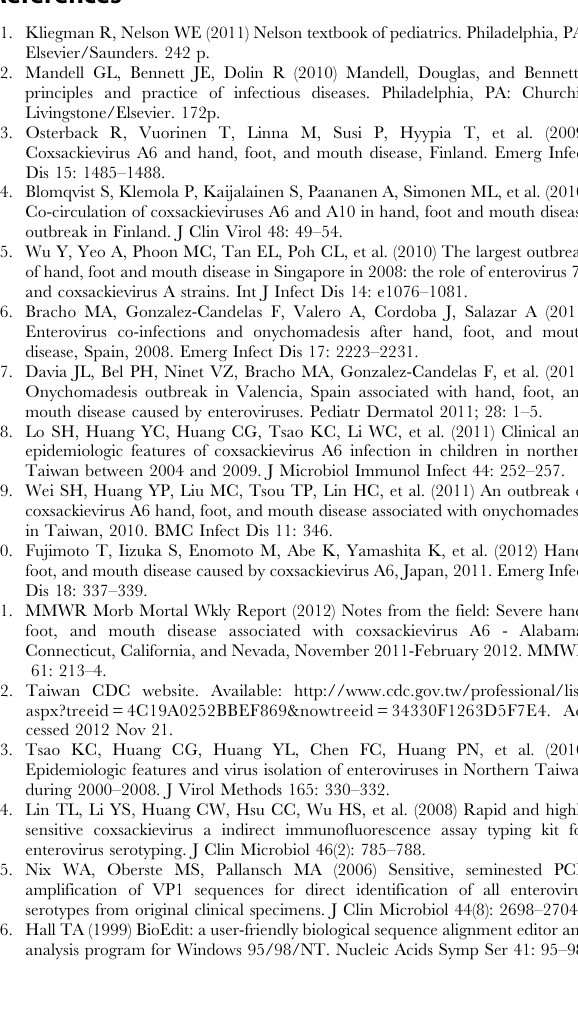
Table S1 Sequences of primers used in this study. (DOC) Table S2 Comparison of nucleotide identities of pro- totype coxsackievirus A6 strain (Gdula) with circulating strains in 2009–10.